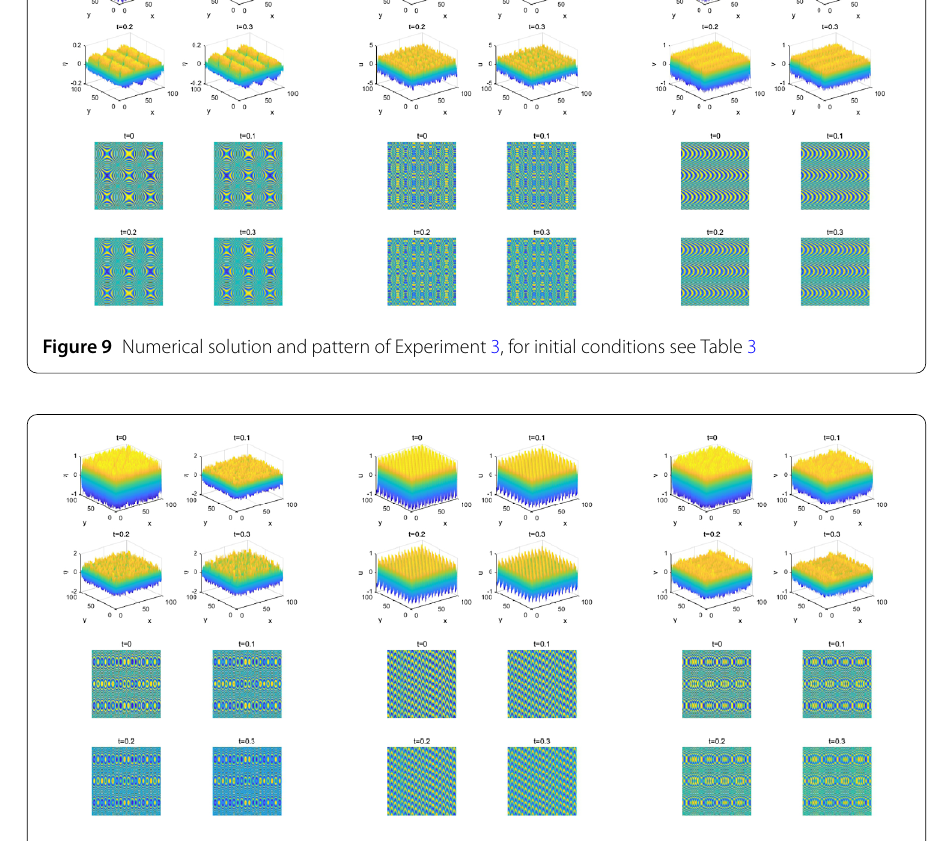
Figure 10 Numerical solution and pattern of Experiment 3, for initial conditions see Table